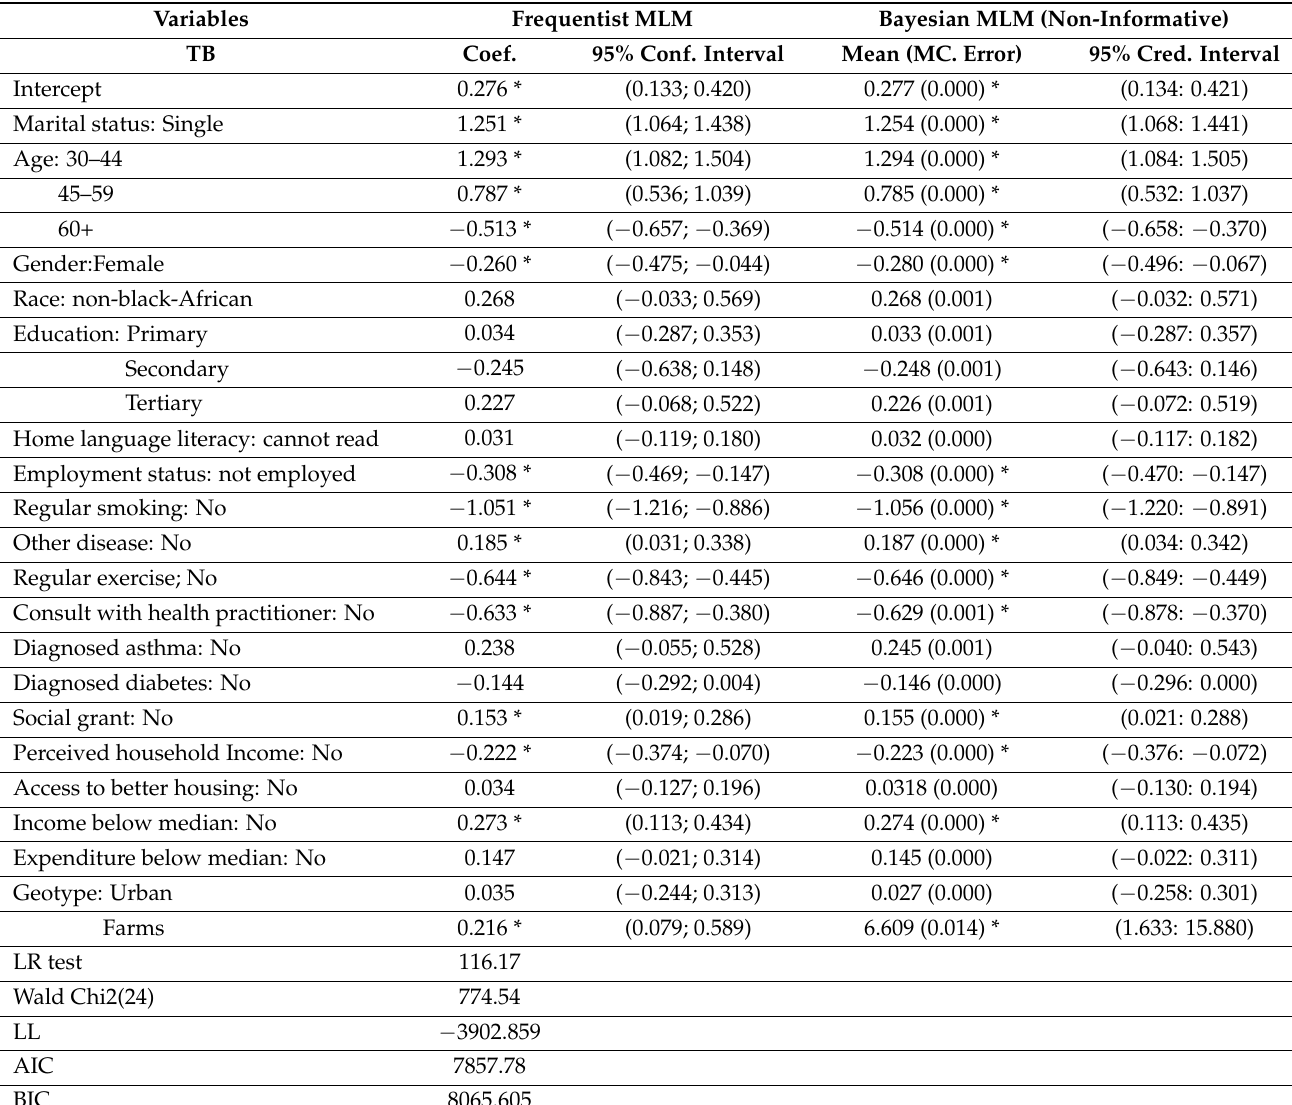
Table 4. Fixed and random effects multilevel analysis of factors associated with TB: two estima- tion